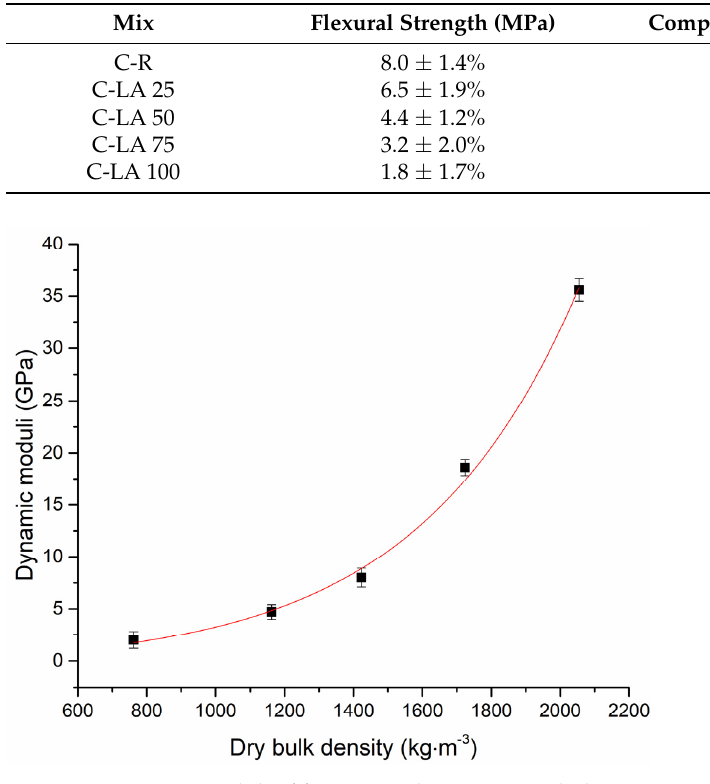
Figure 5. Dynamic moduli of fine-grained concretes with diverse LBW content.